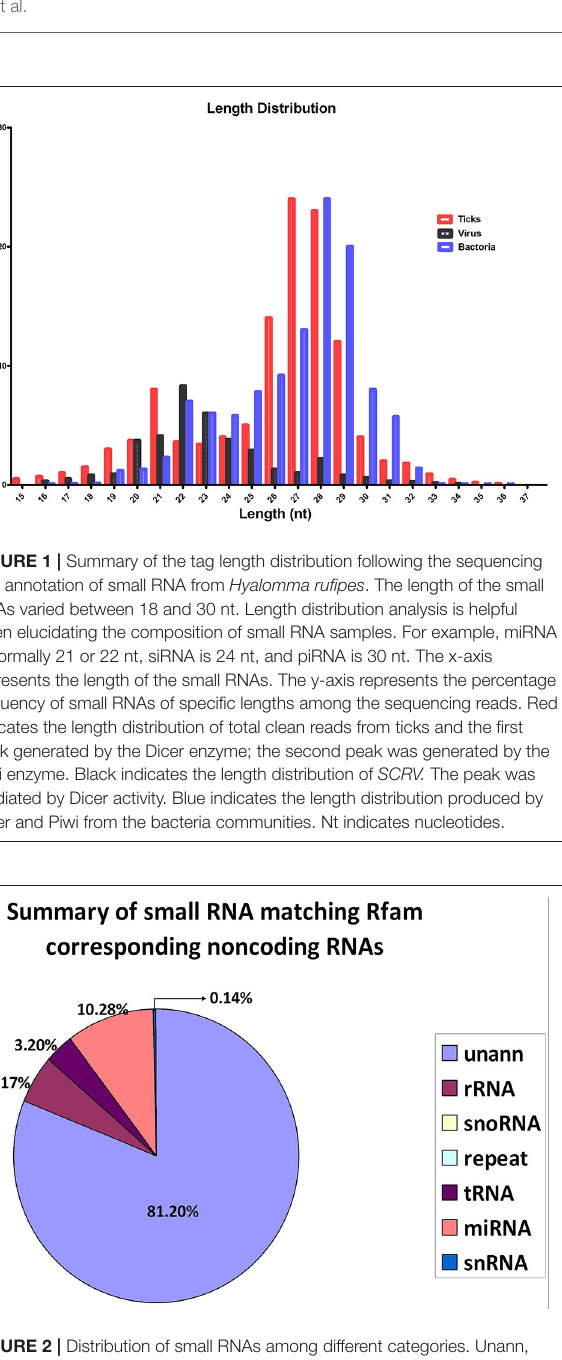
other contaminating sequences from the 50-nt tags. In addition, the sequences were assigned to 3,337,930 unique